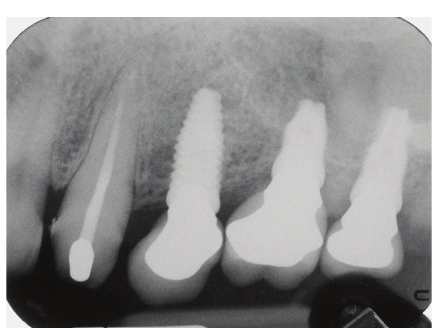
Figure 8: Radiographs taken at 6-month followup.